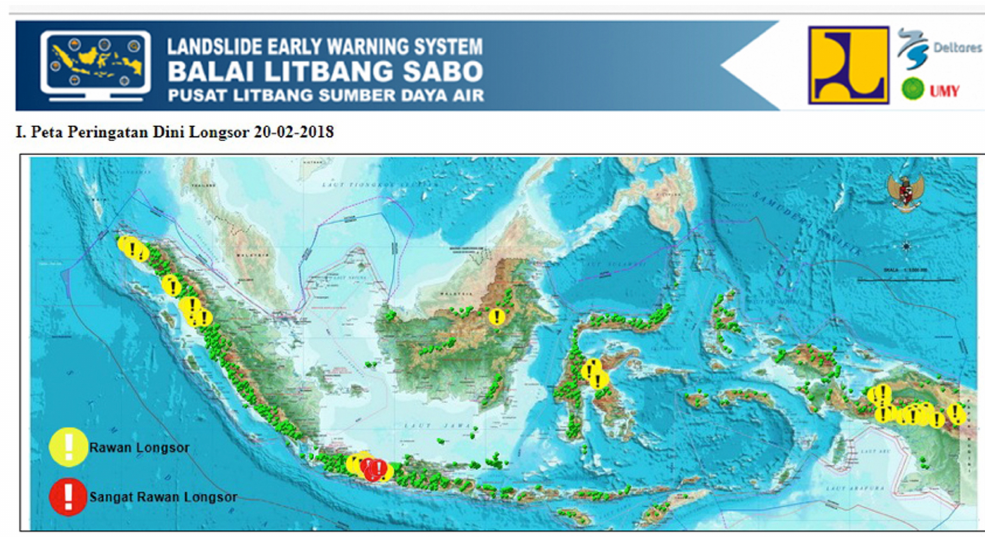
Figure 9. The warning signals issued by the Balai Litbang Sabo Landslide Early Warning System (BLS LEWS) for 20 February 2018.